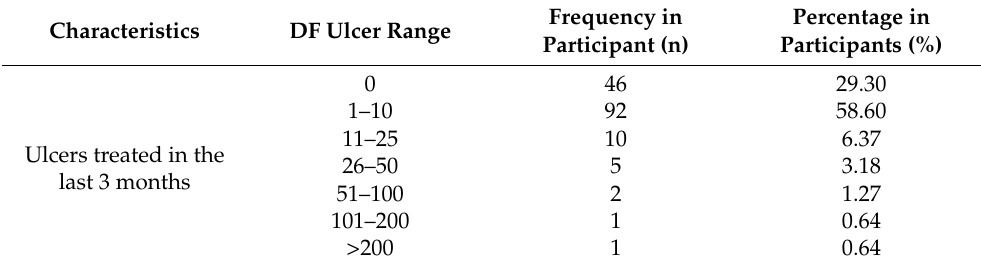
Table 3. DF Ulcer in the last three months. (n =